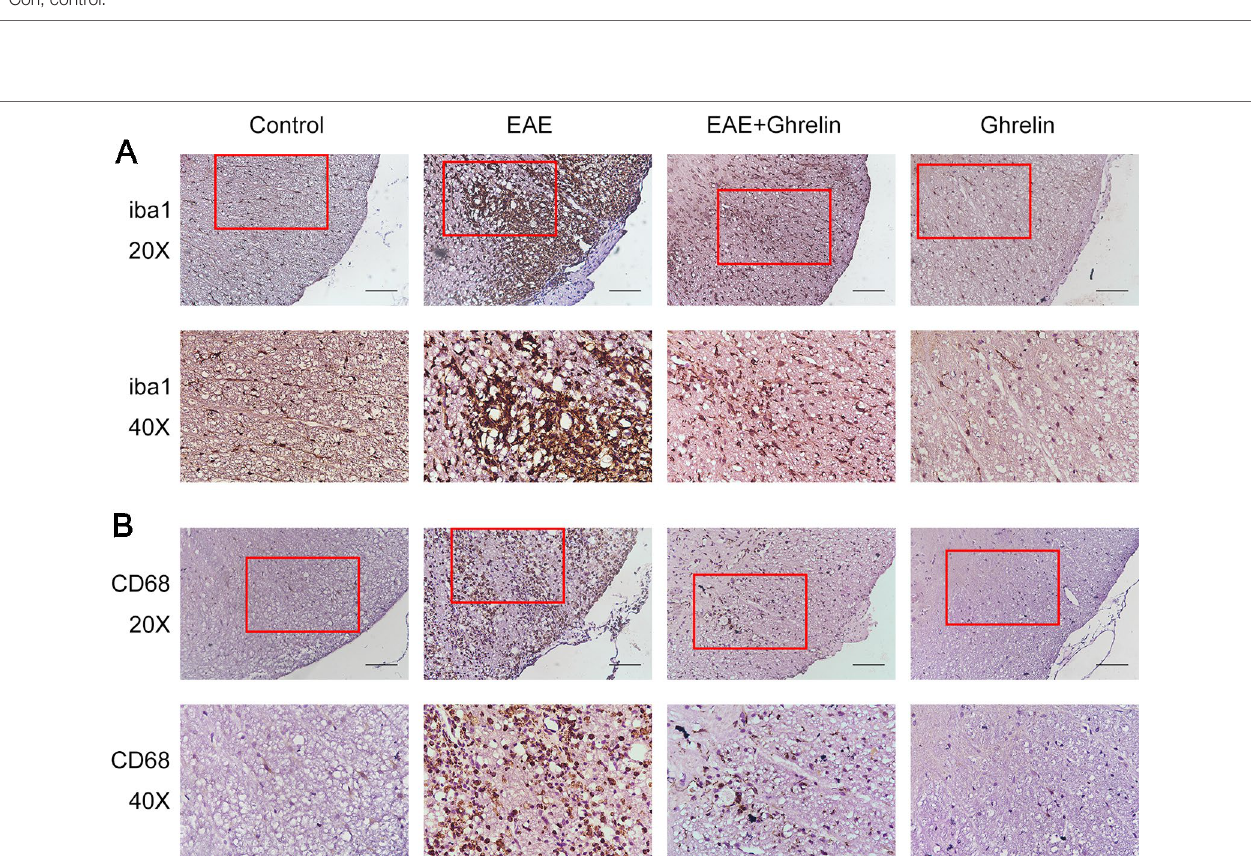
FIGURE 3 | Treatment of ghrelin inhibited microglia aggregation and activation in EAE rats. IHC staining of iba1 (A) and CD68 (B) in the spinal cord tissues. Scale bars: 50 μm.